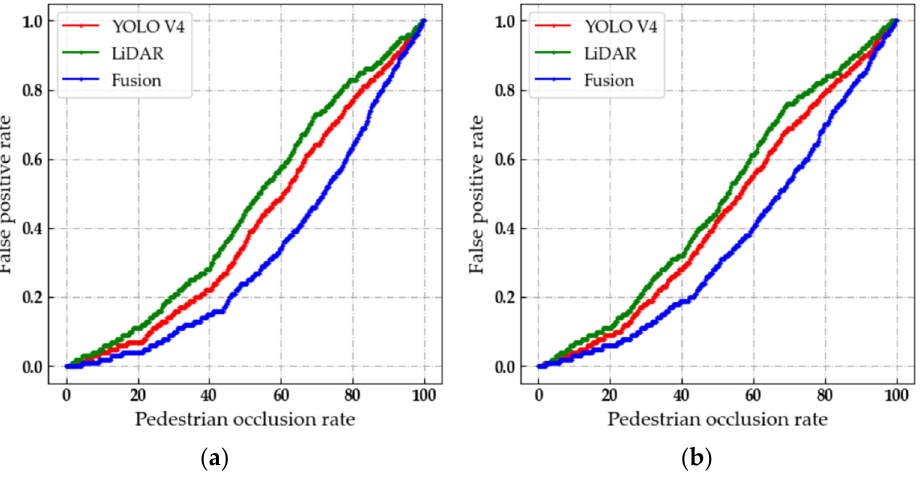
Figure 13. Fitting curves of false positive rate under different scenarios. ( a ) Outdoor environment. ( b ) Academic building.